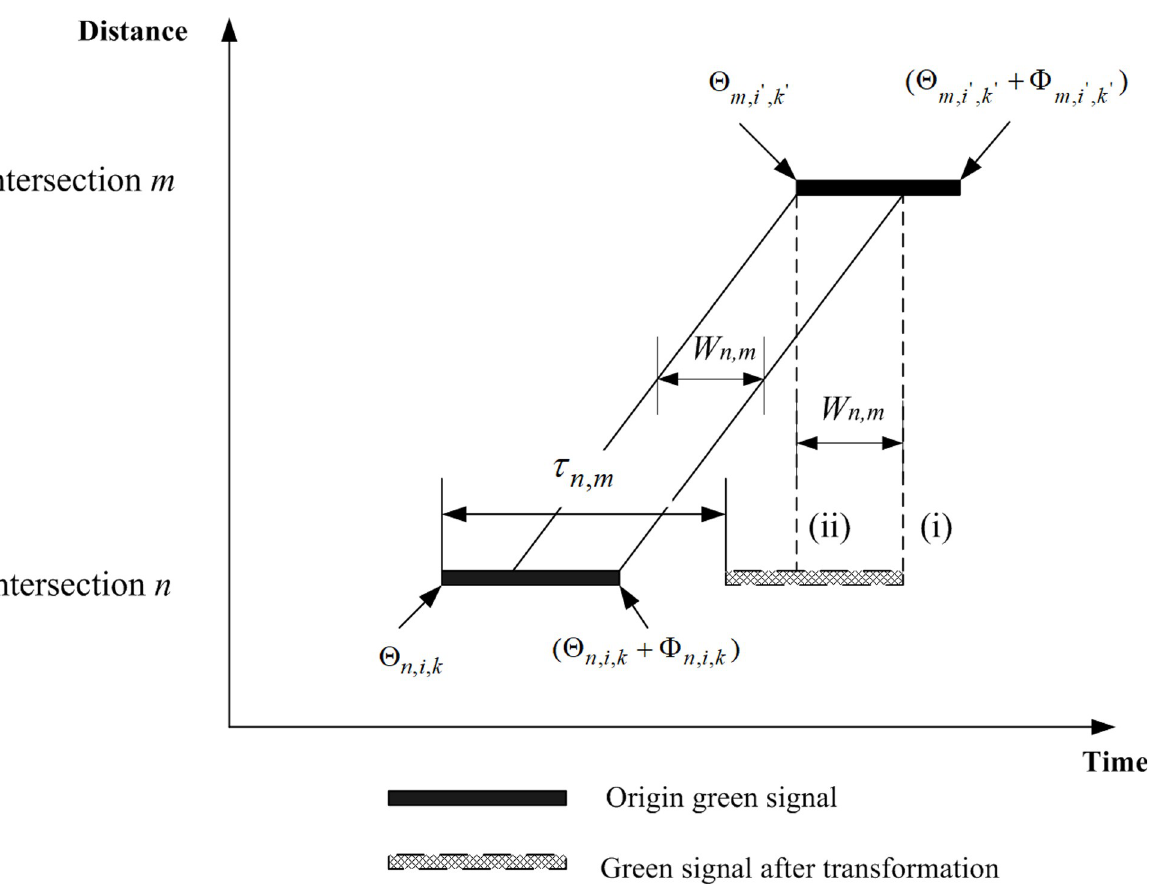
PLOS ONE | https://doi.org/10.1371/journal.pone.0216958 June 10,